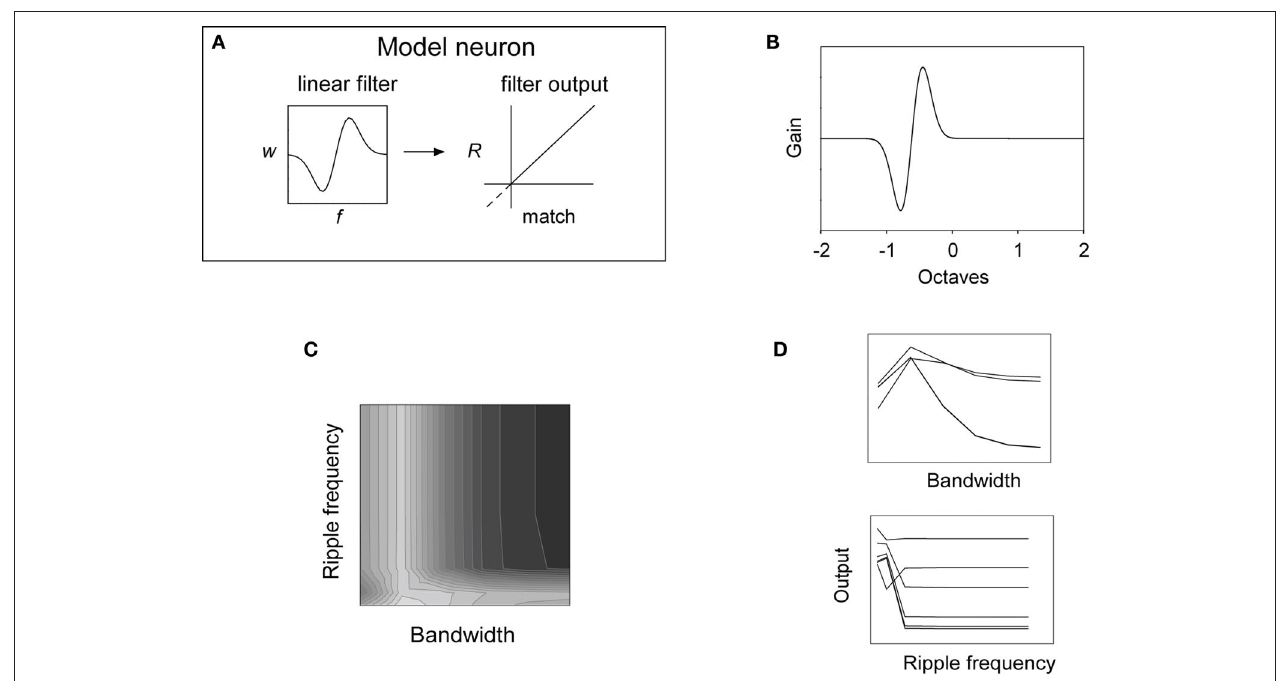
FiGure 9 | (A) Schematic of the neural model presented in Eq. 1, consisting of a linear filter ( left ) with output ( right ) represented by the dashed and solid lines. The solid line in the response plot represents the rectified output of Eq. 2. (B) Gabor filter consisting of 1024 weights [ripple frequency = 0.93 cyc/oct; bandwidth ( σ ) = 0.17 oct; 1/2 power bandwidth = 0.40 oct]. (C) Contour plot